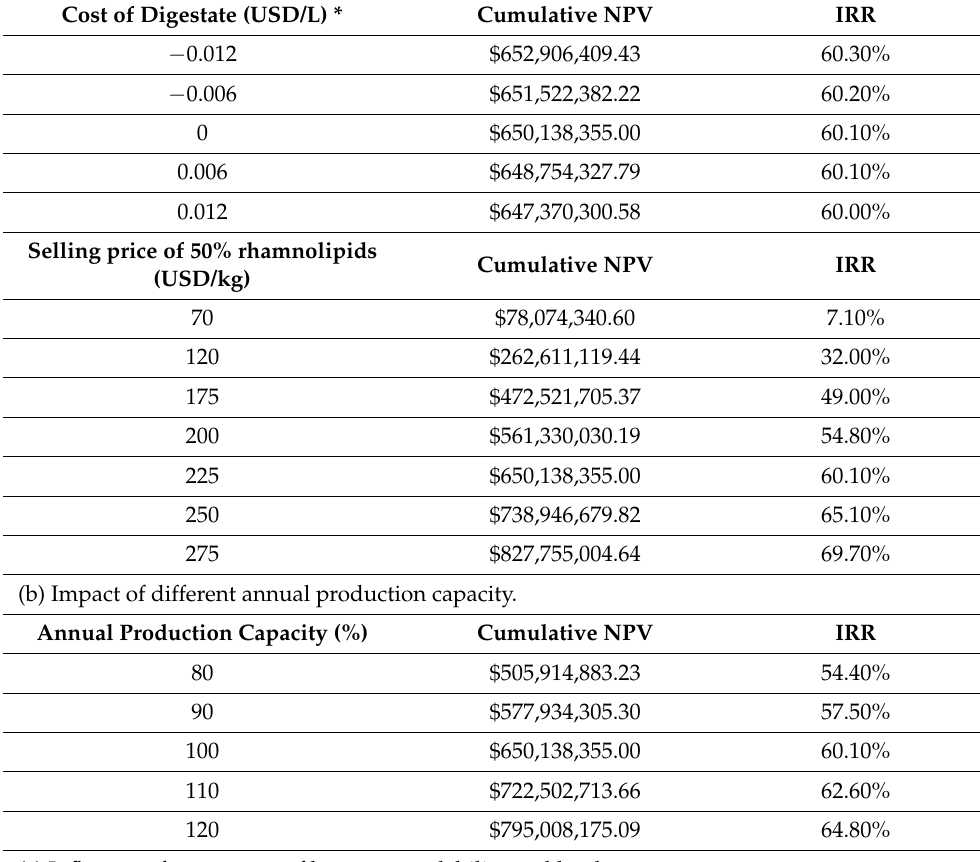
Table 3. Sensitivity analysis of different variables on process economics. ( a ) Effect of cost of digestate and rhamnolipids selling price. ( b ) Impact of different annual production capacity. ( c ) Influence of percentage of hexane recyclability and land rent